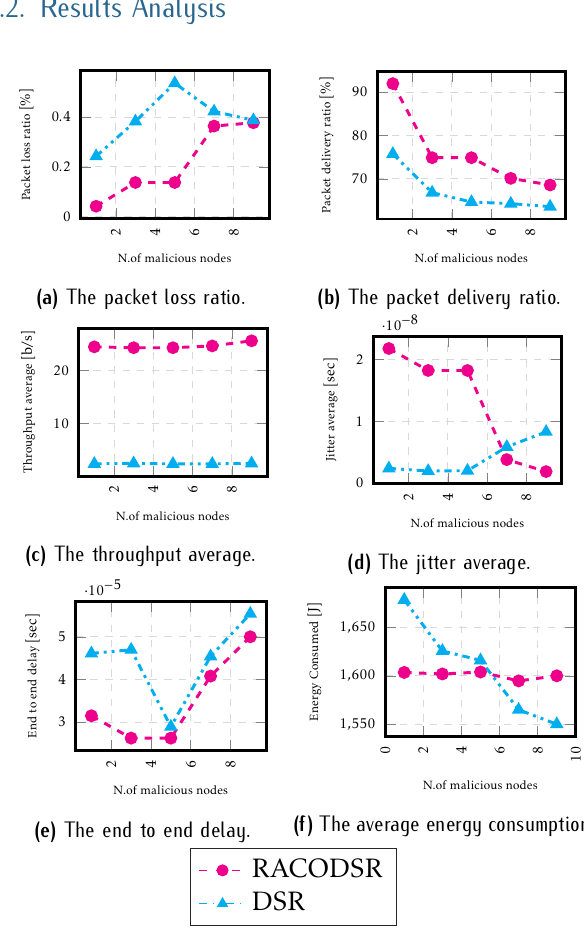
Figure 4. The QoS evaluation in different VANets maliciousness rate scenarios